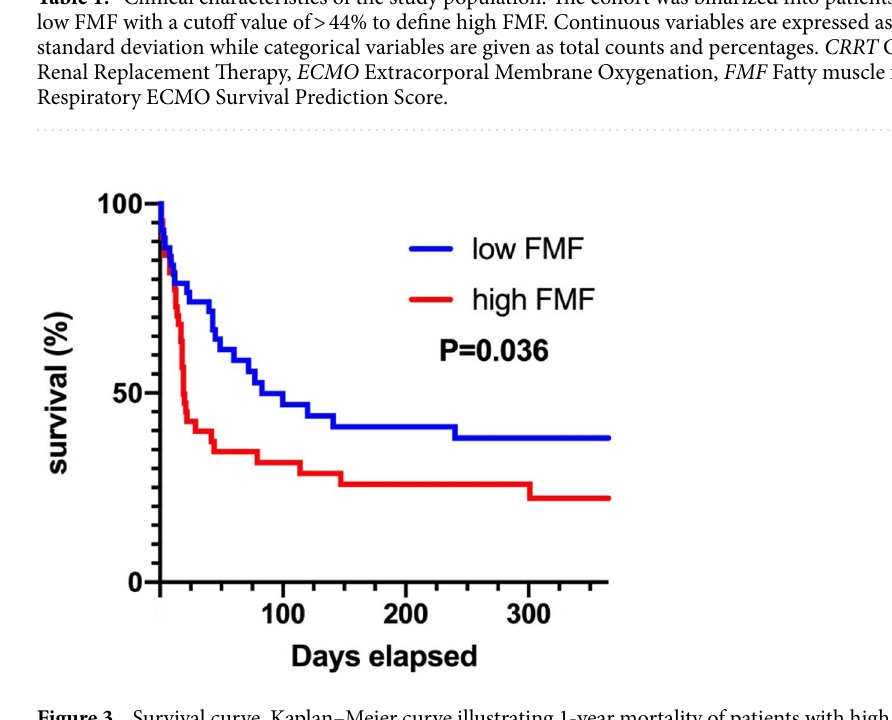
Figure 3. Survival curve. Kaplan–Meier curve illustrating 1-year mortality of patients with high FMF compared to patients with low FMF. The entire study population (n = 87) was binarized based on median FMF with a cutoff value of > 44% to define high FMF. Patients with high FMF displayed significantly increased 1-year mortality following ECMO-implantation for acute respiratory failure (72.7% versus 55.8%, P = 0.036). ECMO Extracorporeal Membrane Oxygenation, FMF Fatty muscle